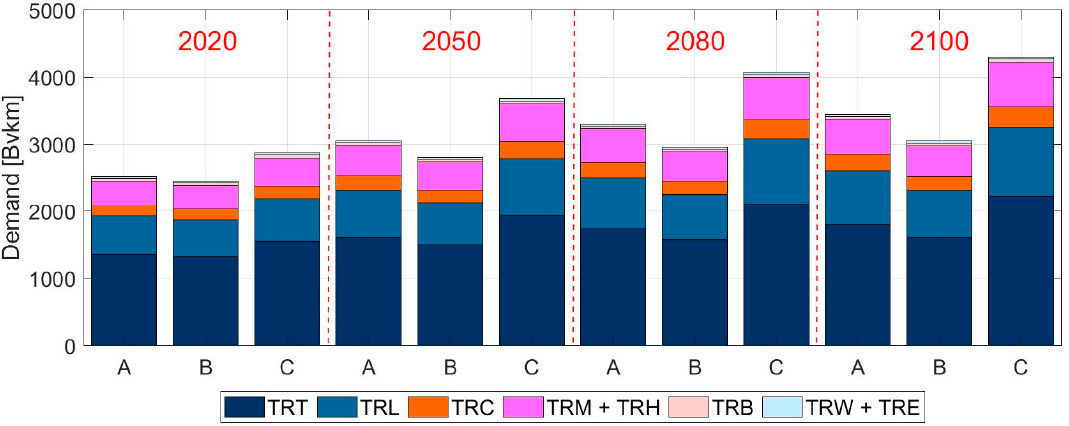
Figure 7. Road transport service demand projection for the di ff erent transport modes at selected time steps in the three storylines.